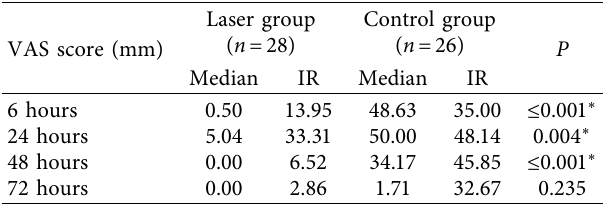
Table 2: Intergroup comparison of the levels of painful symptoms in VAS score (mm) in each time evaluated (nonparametric Mann–Whitney test).